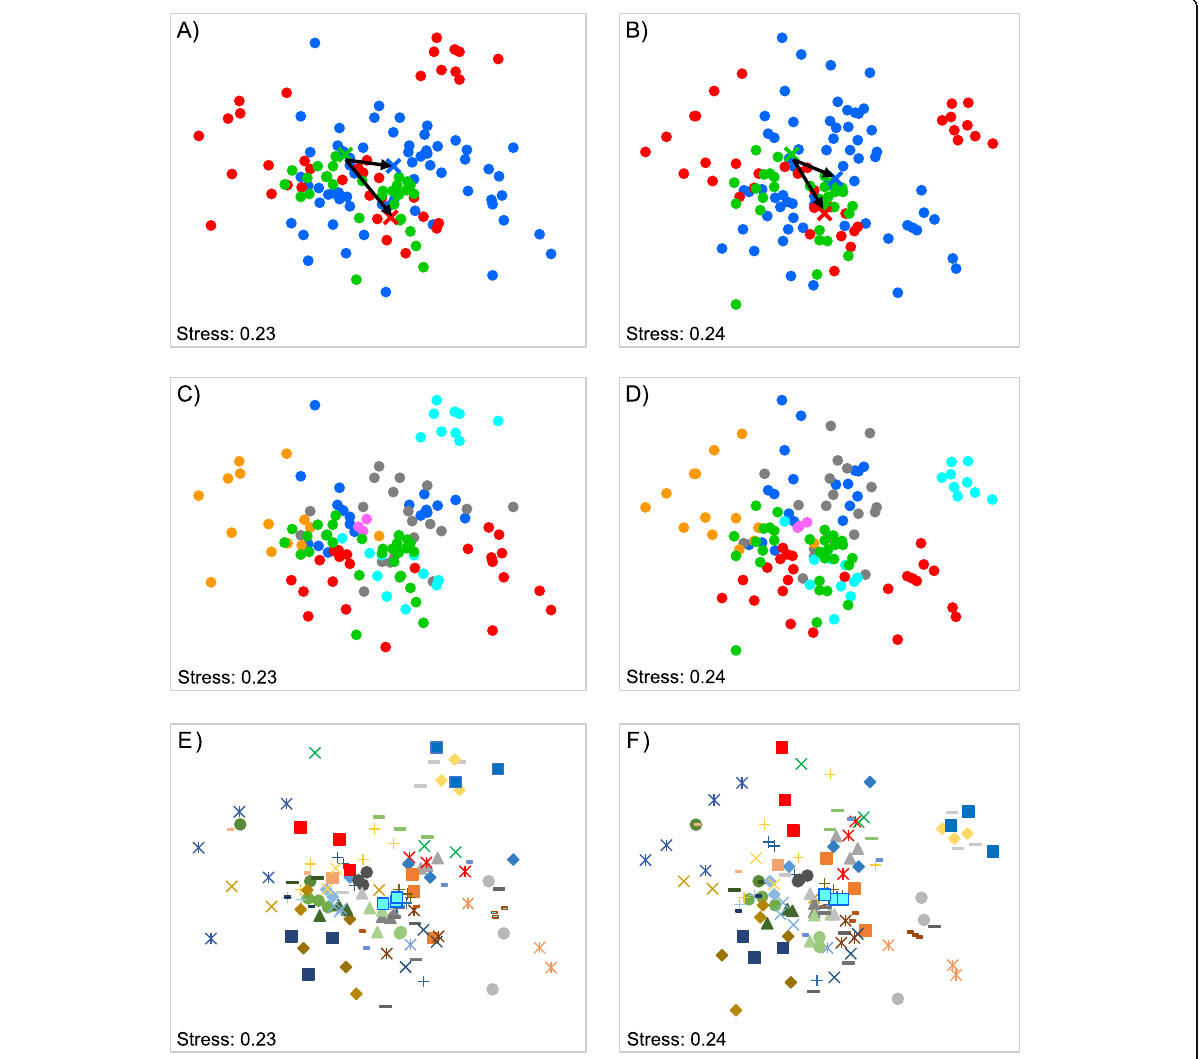
Fig. 4 n MDS for benthic macrofauna in Caucahue Channel fourth-root transformation of Bray-Curtis index. a , b factor ENV; c , d factor CENTER; e , f factor SITE. a , c , e correspond to abundance, and b , d , f ) to biomass. In A and B, crosses indicate centroids for the three groupings: MYT with blue circles, SAL with red and REF with green. In c and d each color represents a farm (Q1: blue, Q9: red, Q11: grey, Q2: orange, Q12: light blue, Q6: pink, REF: green). In e and f each similar symbol/color represents a sampling